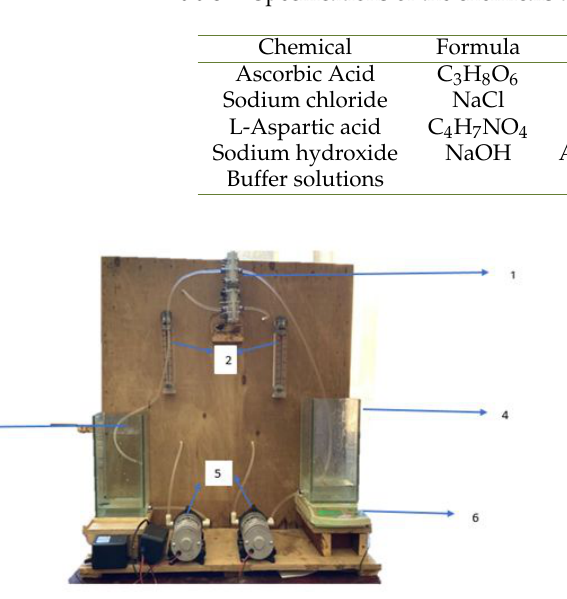
Table 1. Specifications of the chemicals and reagents used in the present work.